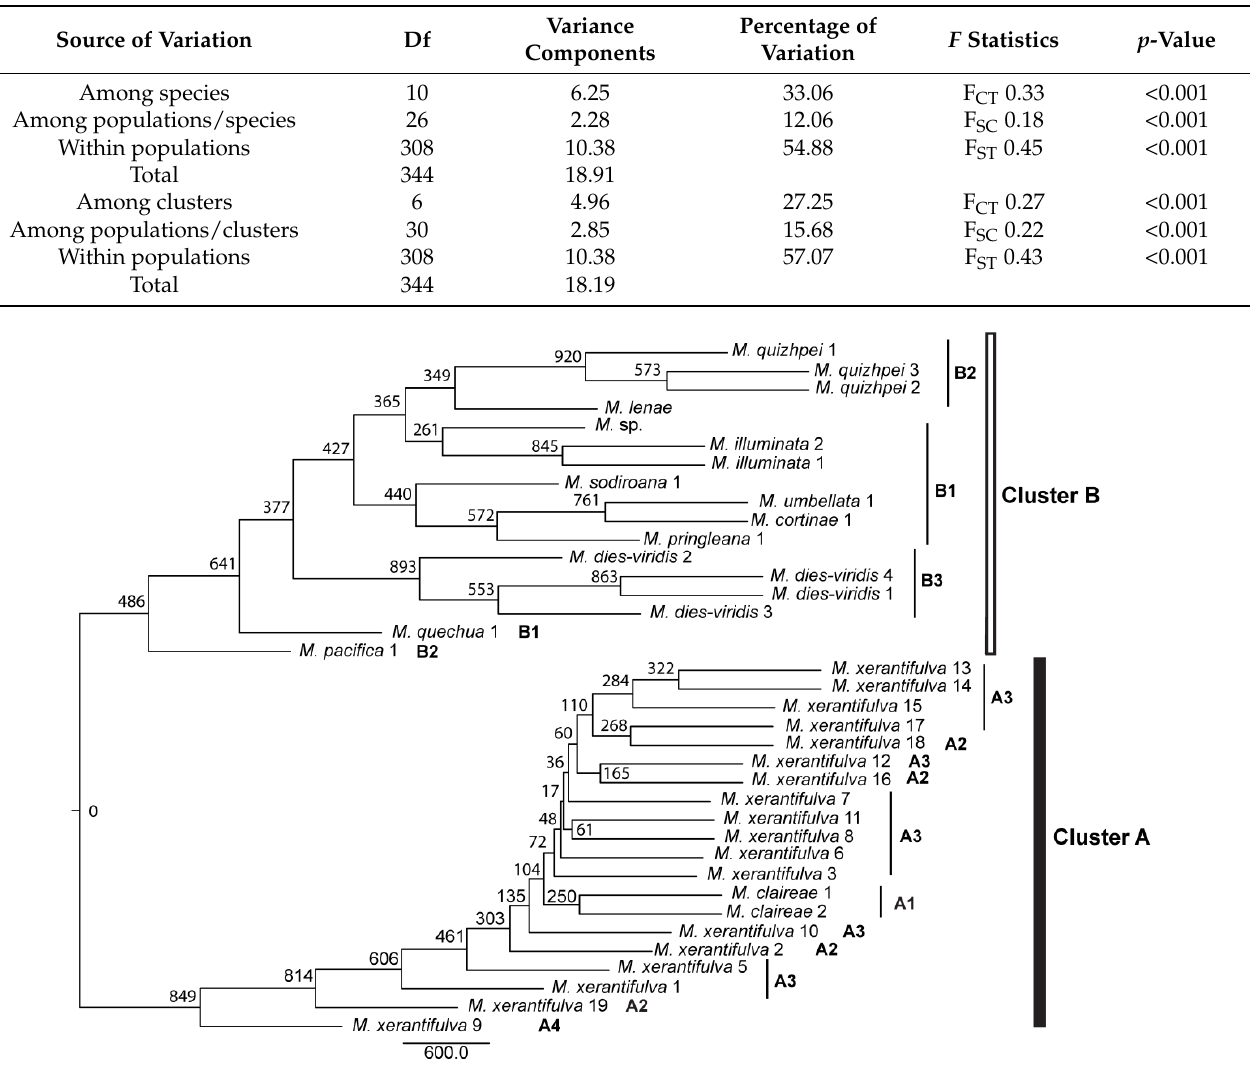
Table 2. Summary of the hierarchical analyses of molecular variance (AMOVA) performed in Arlequin by grouping: (1) the populations by species and (2) by genetic clusters identified by the two-step STRUCTURE analyses. p -values were obtained with 1023 permutations. F CT = variation among groups divided by total variation, F SC = variation among sub-groups within groups divided by the sum of variation among sub-groups within groups and variation within sub-groups, F ST = the sum of variation among groups and variation among sub-groups within groups, divided by total variation.